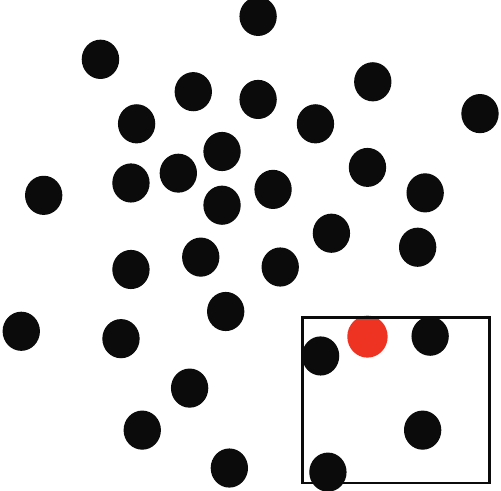
Figure 12: Particle distribution diagram at time t + 2.